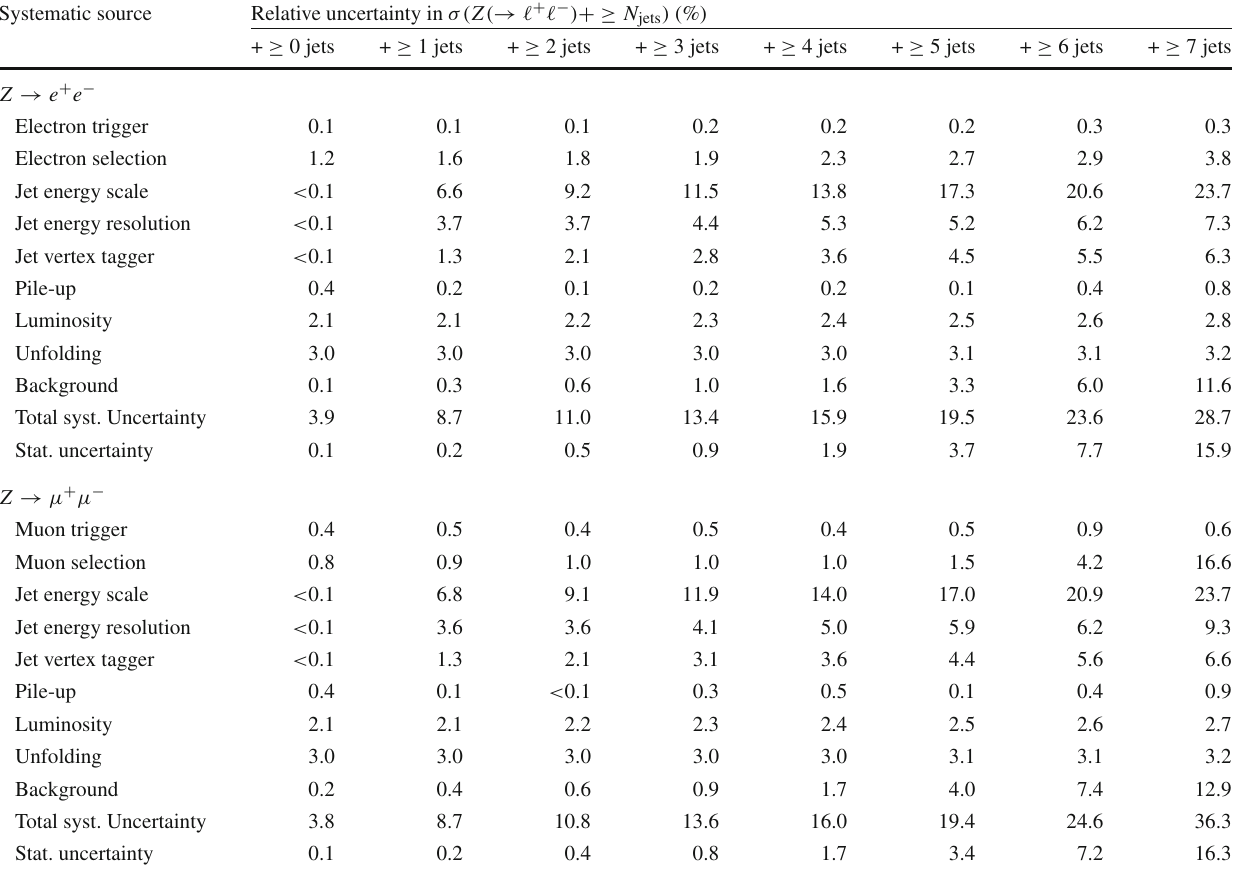
Table 4 Relative statistical and systematic uncertainties (in %) in the measured cross sections of Z + jets production for successive inclusive jet multiplicities in the electron (top) and muon (bottom) channels Systematic